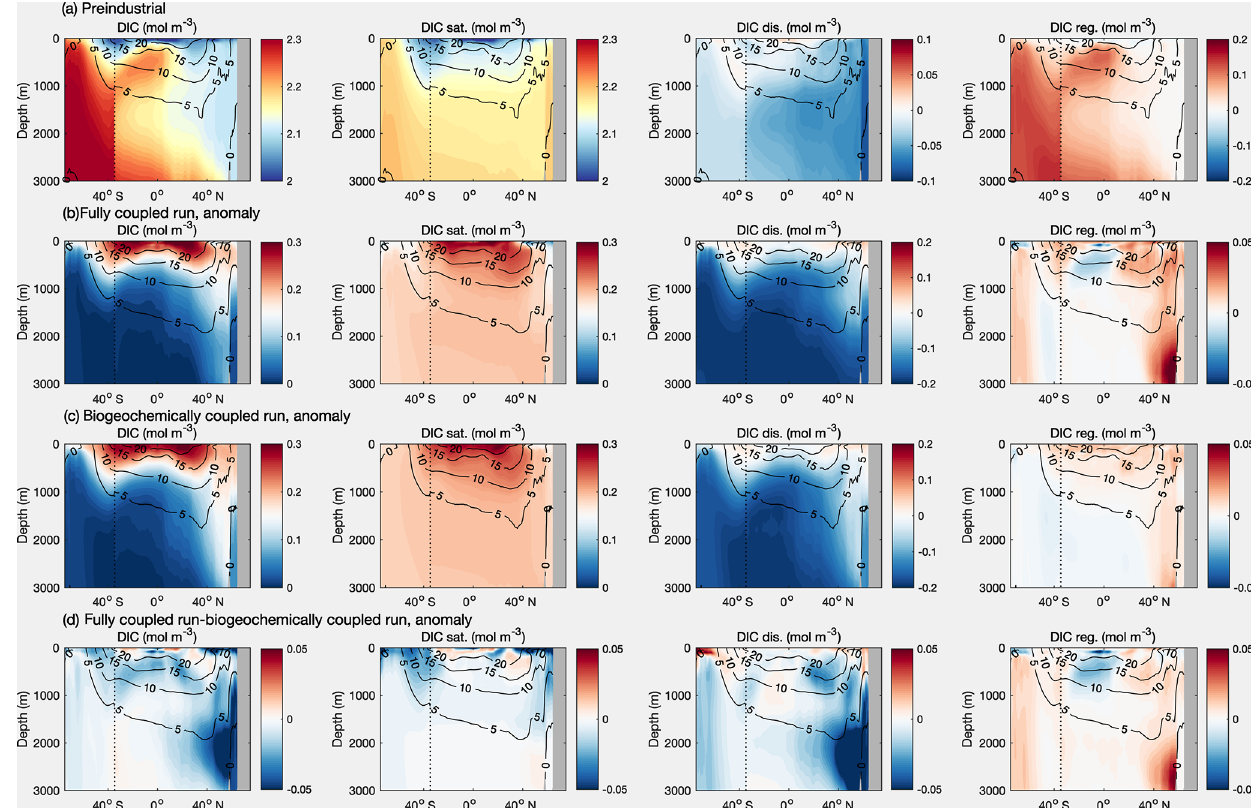
Figure 10. Meridional section of the dissolved inorganic carbon, DIC (molm − 3 ), and constituent carbon pools in UK-ESM1-0-LL for the zonally averaged Atlantic and Southern Ocean: (a) the preindustrial absolute concentrations and (b–d) the anomalies relative to the preindustrial state at year 140 for (b) the COU configuration, (c) the BGC configuration, and (d) the COU minus the BGC configuration. The DIC is separated into saturated carbon, DIC sat , the disequilibrium carbon, DIC disequilib , and the regenerated carbon, DIC regenerated . The Atlantic and Southern Ocean domains are separated by a vertical black